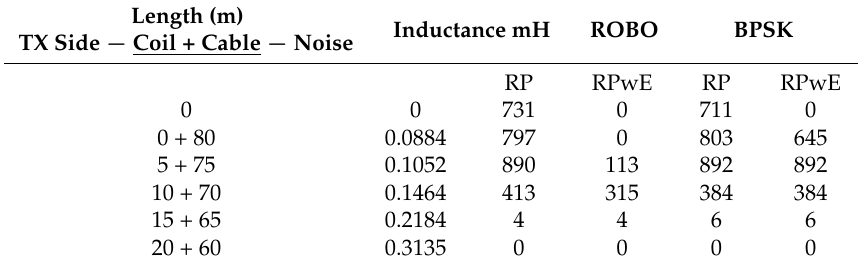
Table 11. ROBO and BPSK Modulation: Coils between the transmitting modem and the noise source. Length